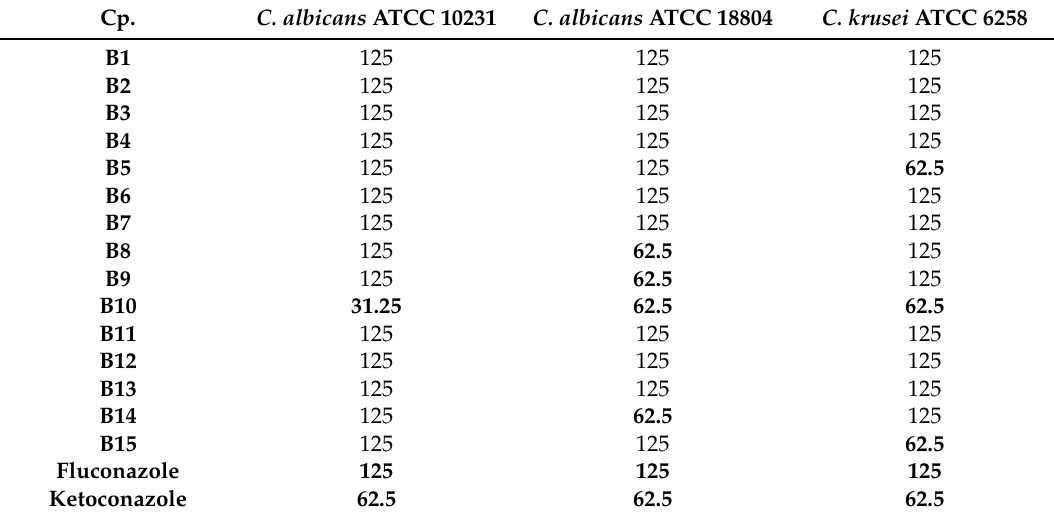
Table 3. Minimum Fungicidal Concentration—MFC (in µ g/mL) of compounds B1 – B15 .